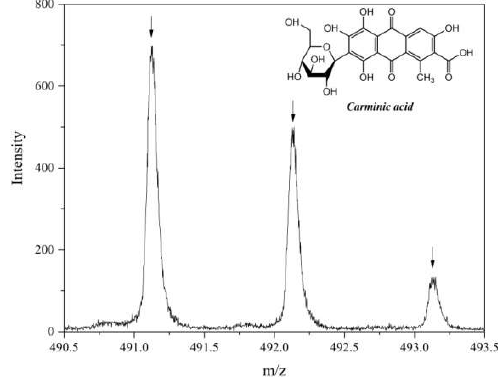
Figure 3. TOF-SIMS spectra of (C 22 H 20 O 13 -H) − ion emitted from carminic acid.